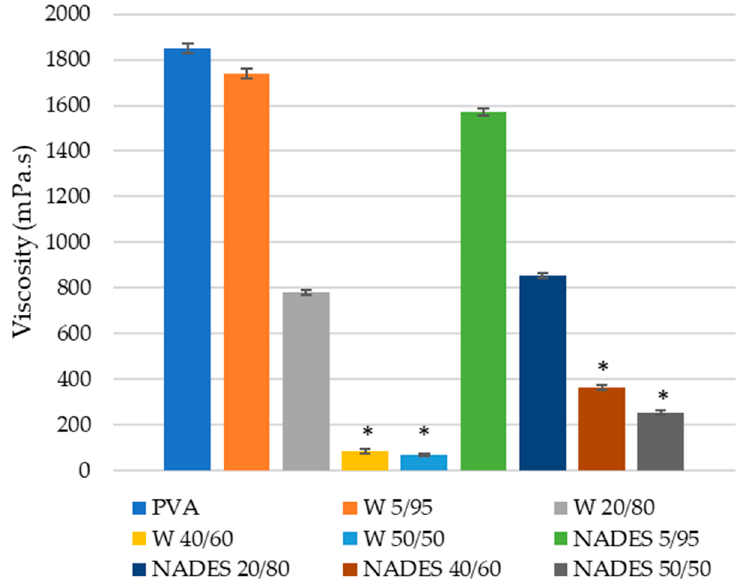
Figure 4. Viscosity (mPa.s) of the emulsions used in the electrospinning. *—statistical differences for p < 0.05.